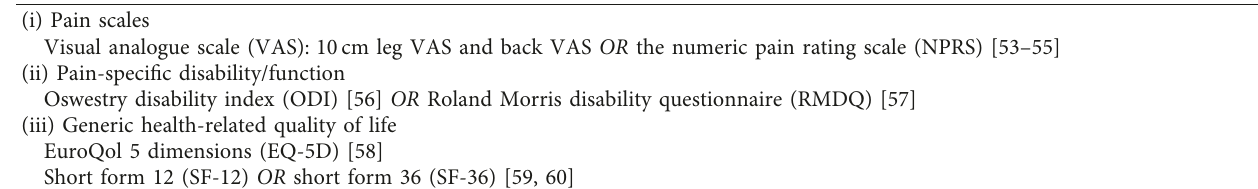
Table 2: Validated questionnaires recommended for completion by patients to assess pain severity, function, and health-related quality of life.